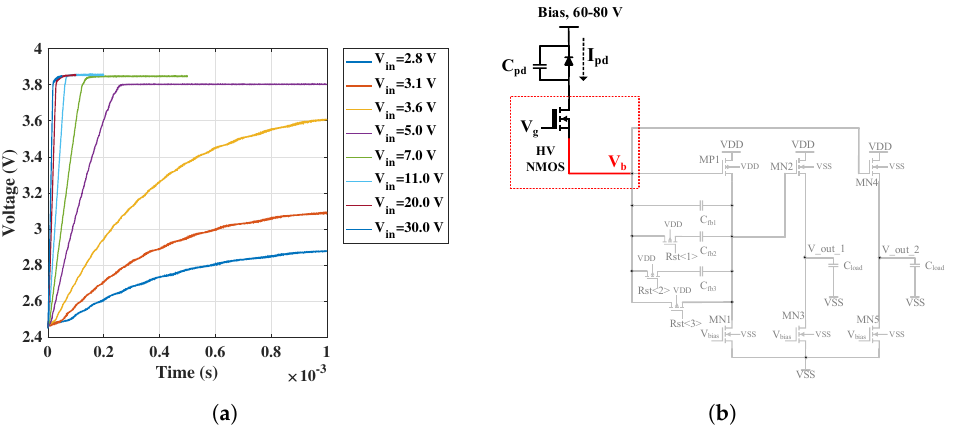
Figure 10. Voltage limiting functionality: ( a ) rise in the CTIA input node V b ; and ( b ) readout schematic- Input node highlighted.